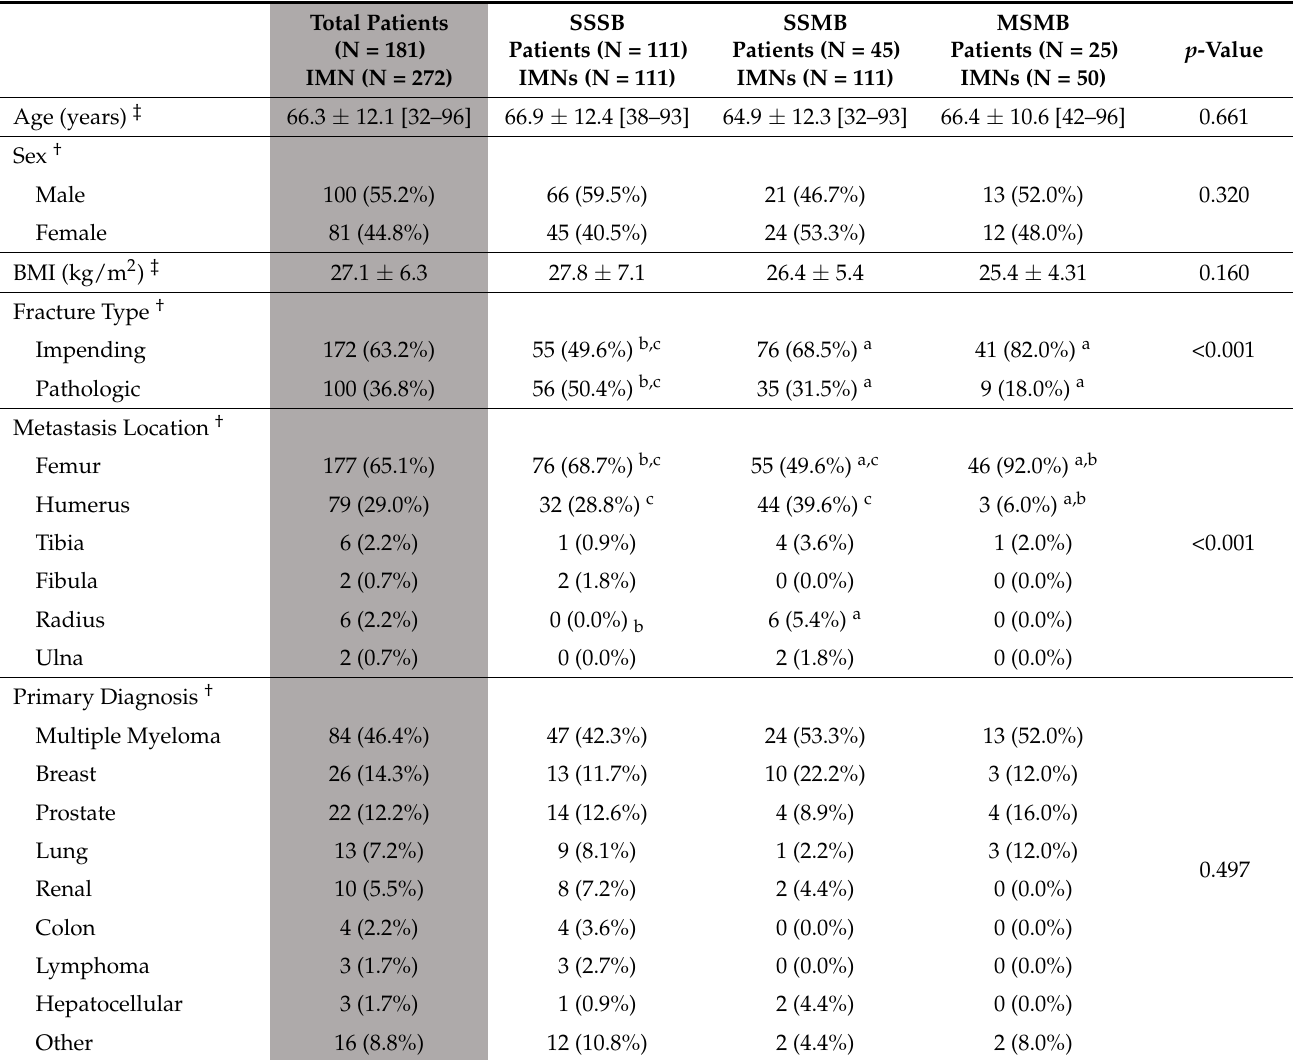
Table 1. Demographic characteristic of study